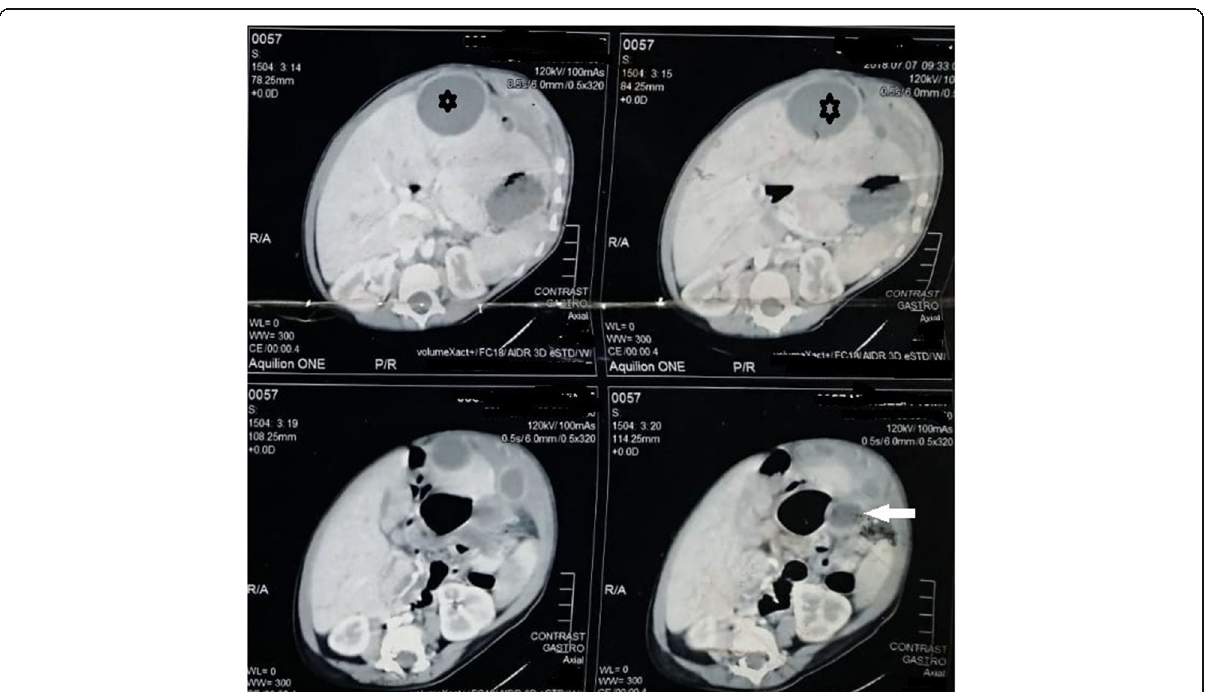
Fig. 1 Showing a well-circumscribed collection in the left lobe of the liver (*). Note a hypodense area in relation to stomach representing gastric duplication cyst (white arrow)